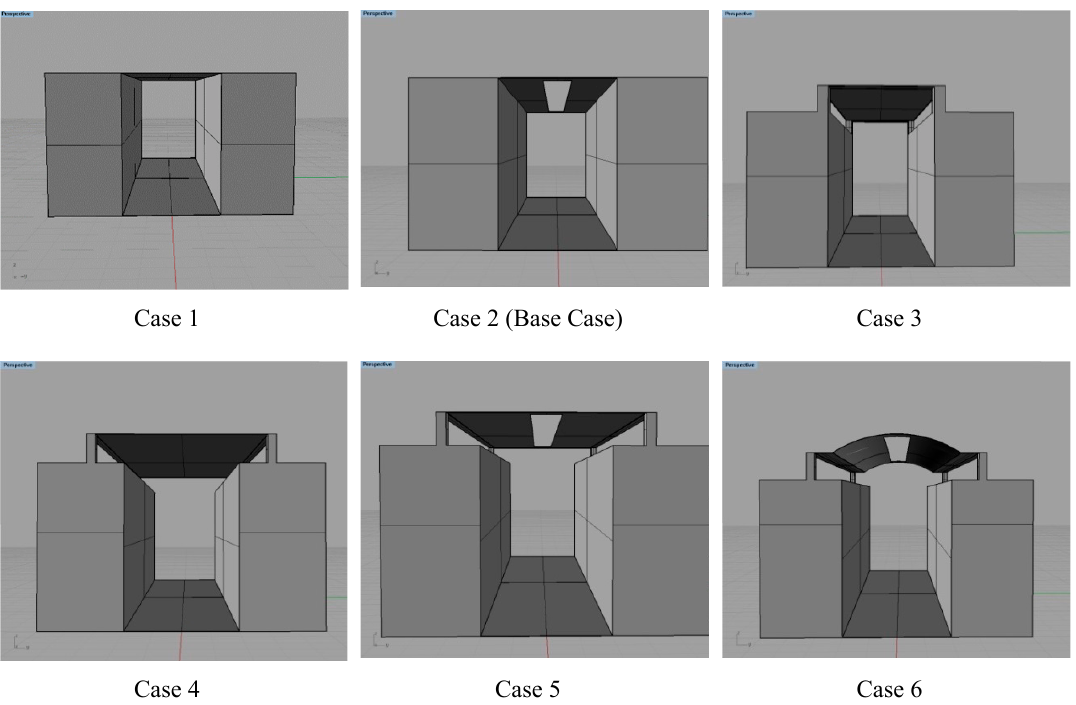
Figure 3. The examined case studies, including specific changes in the roof form and opening locations.